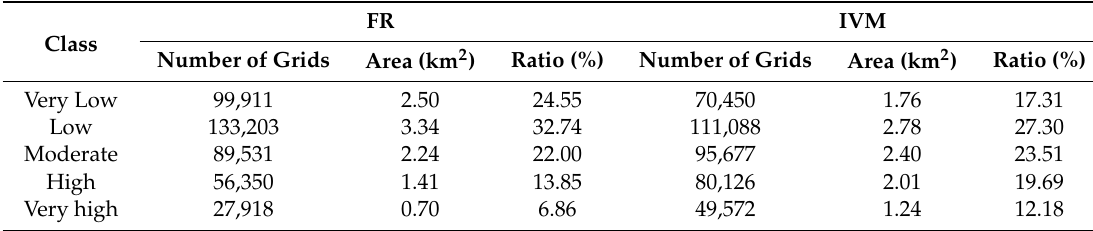
Table 3. Mass-wasting susceptibility mapping results in the study